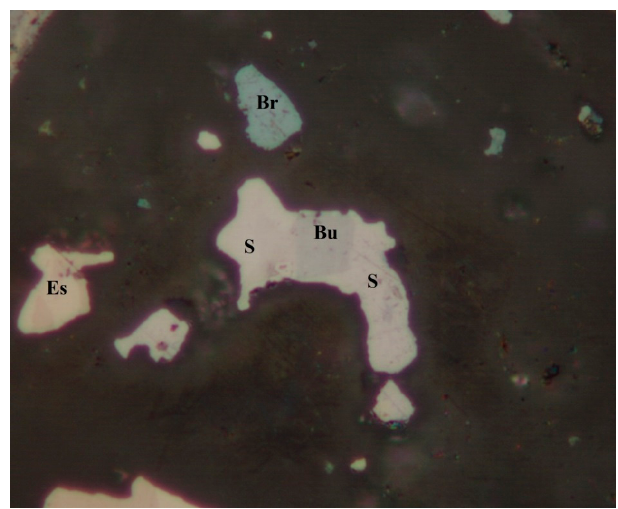
Figure 49. Brown-grey sabatierite is intergrown with dark grey bukovite. Reflected light, one polarizer. FOV 90 μ m. P ř íbram, a dump of the shaft 16. Photo by P. Škácha.